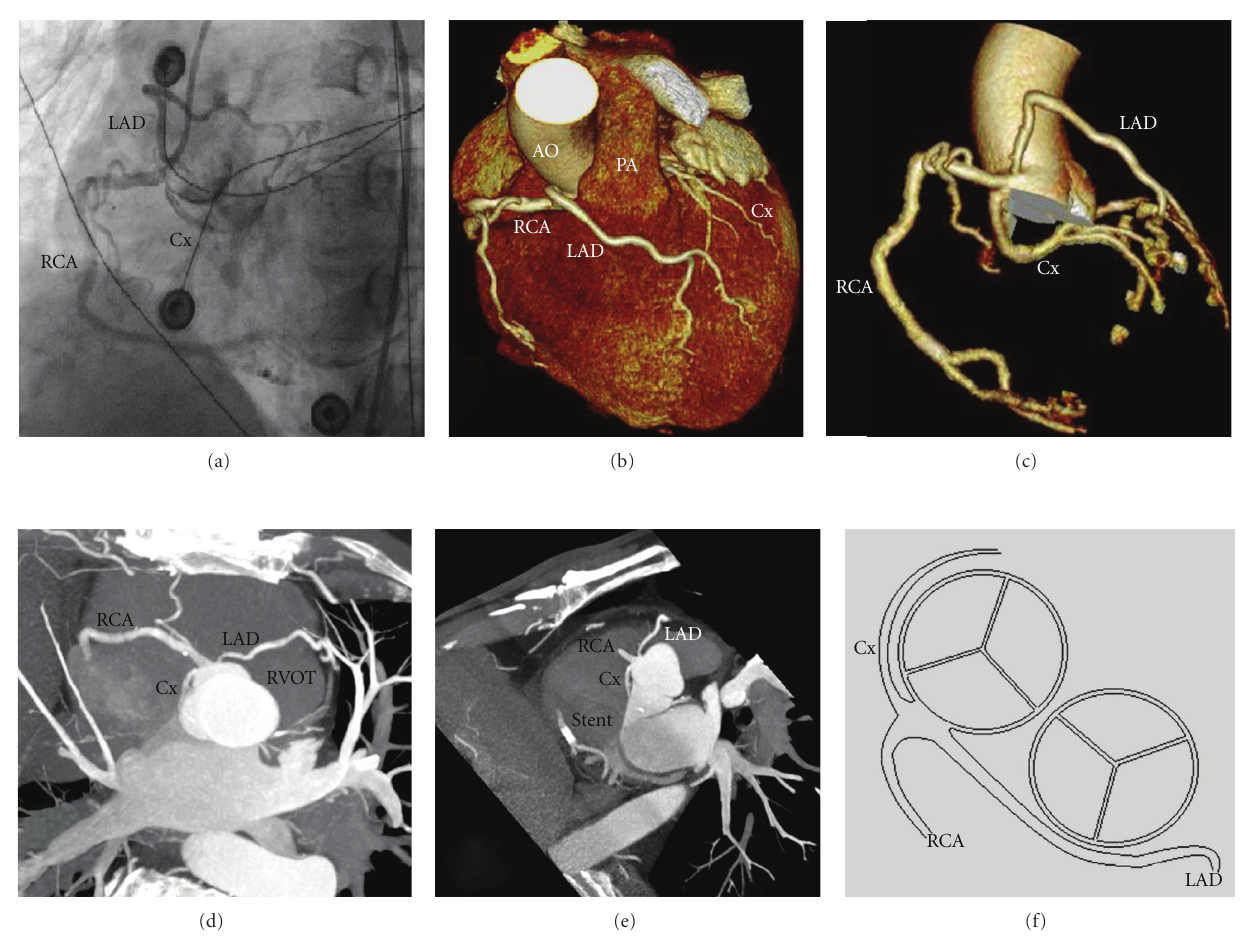
Figure 1: (a) Conventional coronary angiogram in left anterior oblique projection picturing three coronary arteries originating from the right sinus of Valsalva. (b) Coloured volume rendering showing the LAD crossing ventral to the pulmonary artery. (c) A three-dimensional reconstruction showing 3 coronary arteries arising from the right sinus of Valsalva. (d) and (e) Contrast-enhanced 64-slice CT coronary angiography showing a solitary coronary ostium with a visible stent in the distal segment of the RCA. (f) Schematic drawing of the coronary